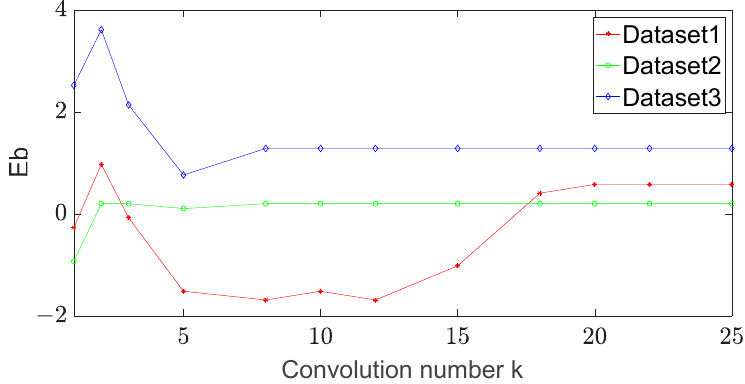
Figure 6. The error of the short axis vs. the convolution number in different datasets.